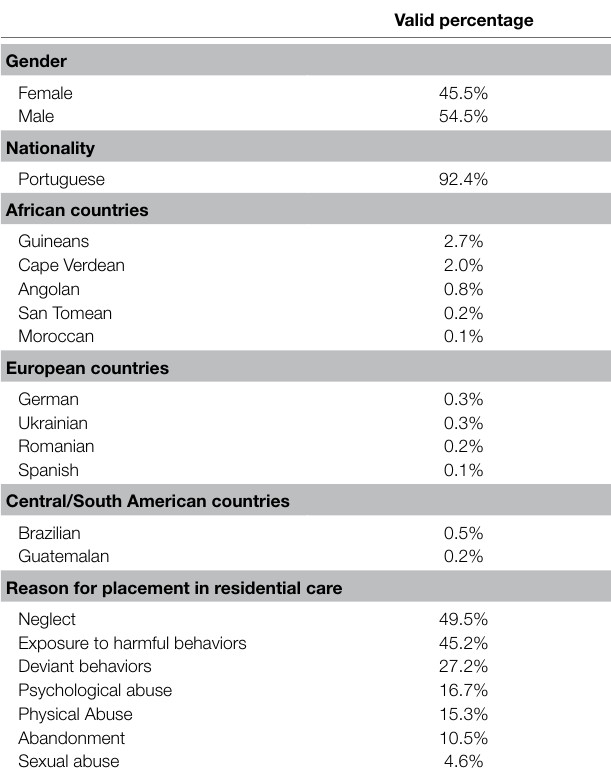
TABLE 1 | Socio-demographic characteristics of the study